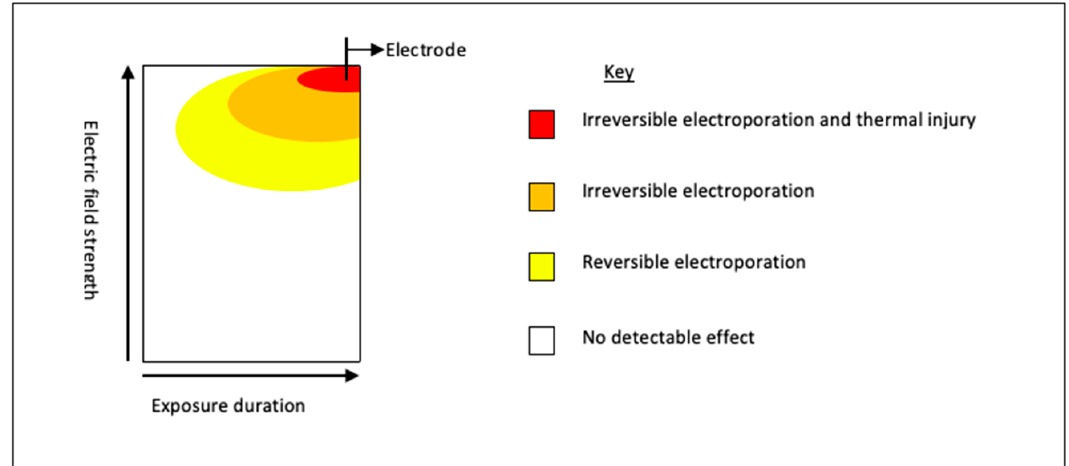
Figure 4. Schematic representation of the basic relationship between electric field strength and length of pulse; key parameters in establishing electroporation. For electroporation to occur, the transmembrane potential difference needs to be between 0.7 and 1 volts [123], once this is achieved, pores form. With increasing voltage and/or increasing length of treatment, these membrane changes become permanent, i.e., IRE resulting in cell death [123].